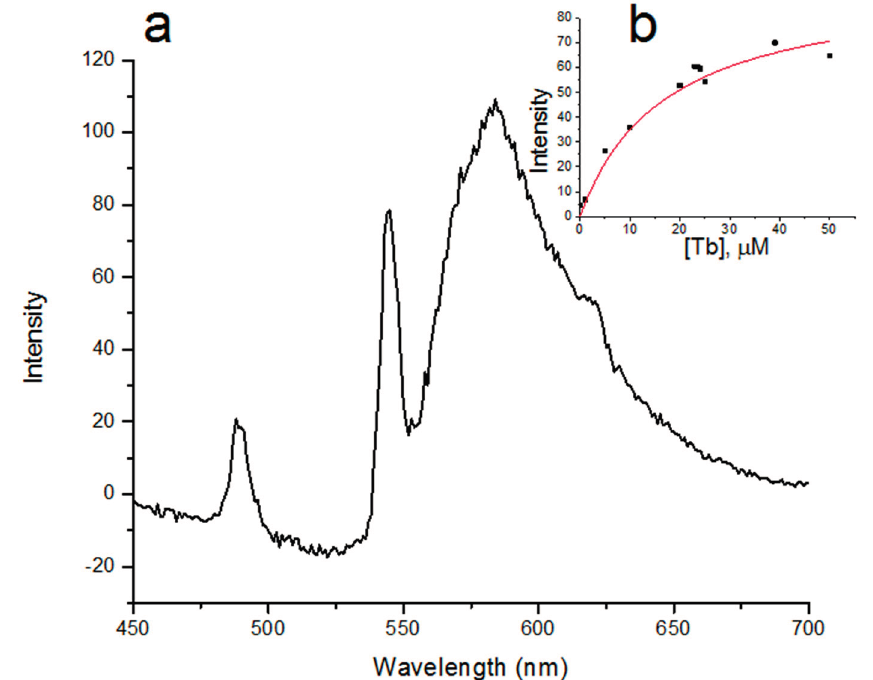
Figure 7. ( a ) Spectrum of the sensitized fluorescence of TagRFP in the Tb 3+ -TBP-19-TagRFP sensor; ( b ) The dependence of sensitized fluorescence intensity of TagRFP, which was calculated by subtraction of intensity of the photobleached sample from the intensity of the non-bleached sample corrected for reabsorption, on the Tb concentration at 606